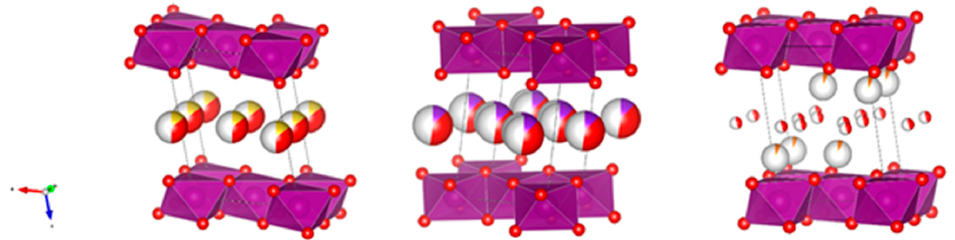
Figure 1. Structures of sodium, potassium and magnesium birnessites, respectively (violet: manganese, red: oxygen, yellow: sodium, indigo: potassium, and orange: magnesium). The large spheres with red regions indicate the presence of water together with the corresponding cations in the interlayer space.